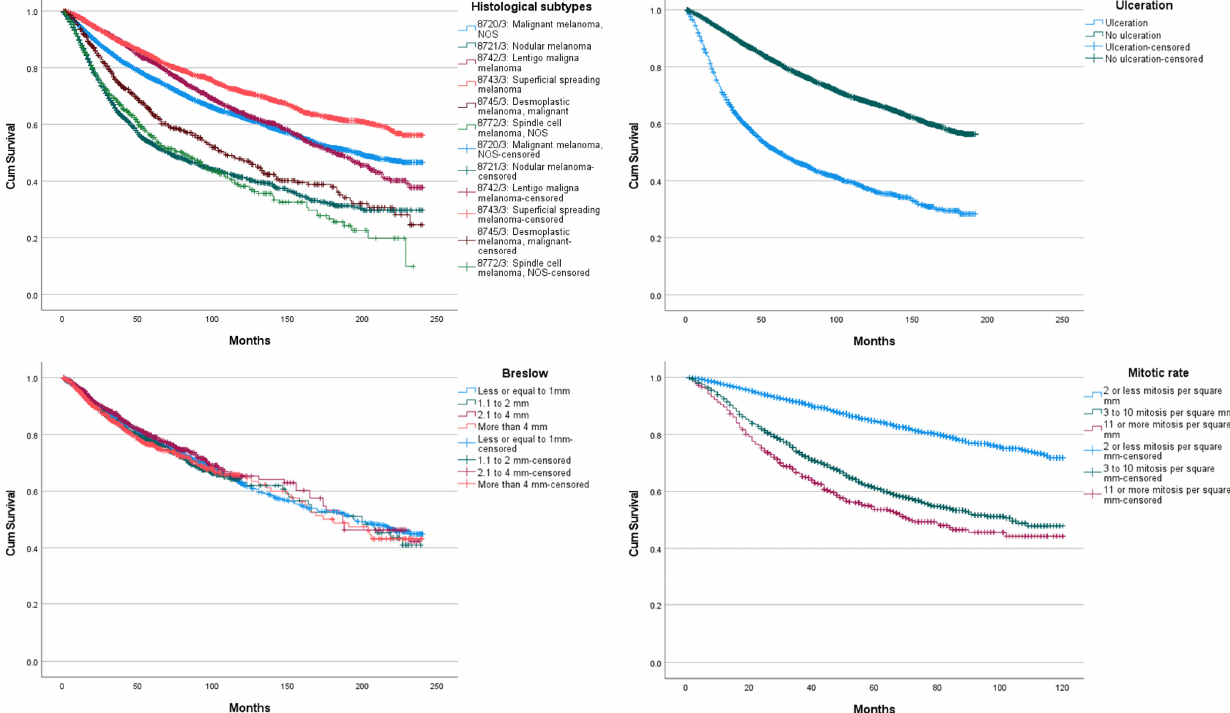
Figure 2. Overall survival curves, according to histological subtype, presence of ulceration, Breslow thickness, and mitotic rate.